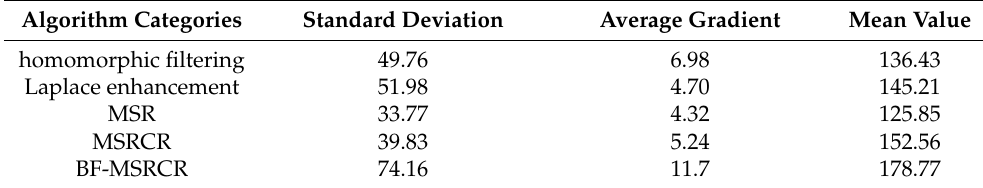
Table 2. Downhole image enhancement quality